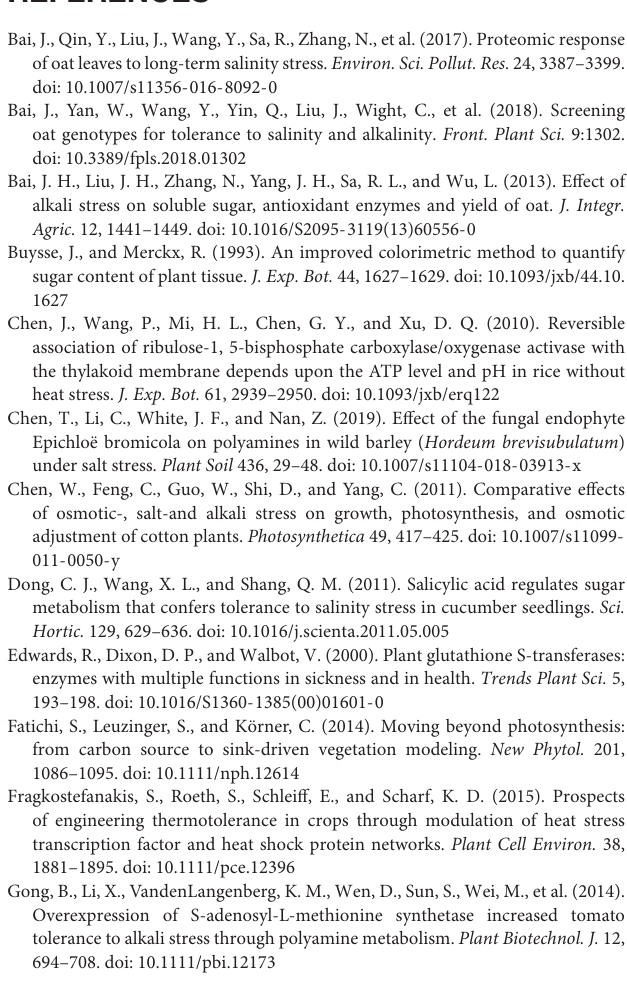
Supplementary Figure 5 | (A) GO and (B) KEGG analysis of differentially expressed proteins in leaves at AS vs. Spm. The color gradient indicated significance, ∗∗∗ indicated P < 0.001, ∗∗ indicated P < 0.01, ∗ indicated Supplementary Figure 6 | Effects of spermine on proline contents under alkali stress. CK, control; AS, alkali stress (35 mmol.L − 1 Na 2 CO 3 :NaHCO 3 = 1:1); Supplementary Figure 7 | (A) GO and (B) KEGG analysis of differentially expressed proteins in roots at AS vs. AS + Spm. The color gradient indicated significance, ∗∗∗ indicated P < 0.001, ∗∗ indicated P < 0.01, ∗ indicated Supplementary Figure 8 | The quantitative RT-PCR analysis of some genes. The values are the mean ± SE of three independent biological replicates normalized against the reference gene Actin. Varied letters: significant differences at the 0.05 level. SUC , sucrose synthase type 3; RUB , RuBisCO large subunit-binding protein subunit beta; COP , coproporphyrinogen III oxidase; ADZM , ATP-dependent zinc metalloprotease FTSH 8; PROGO , protoporphyrinogen oxidase; CYT , cytochrome f; PHO10 , photosystem II 10 kDa polypeptide; PIP1-1 , aquaporin PIP1-1; POLYO , polyphenol oxidase; GLUEI , glucan endo-1,3-beta-glucosidase, acidic